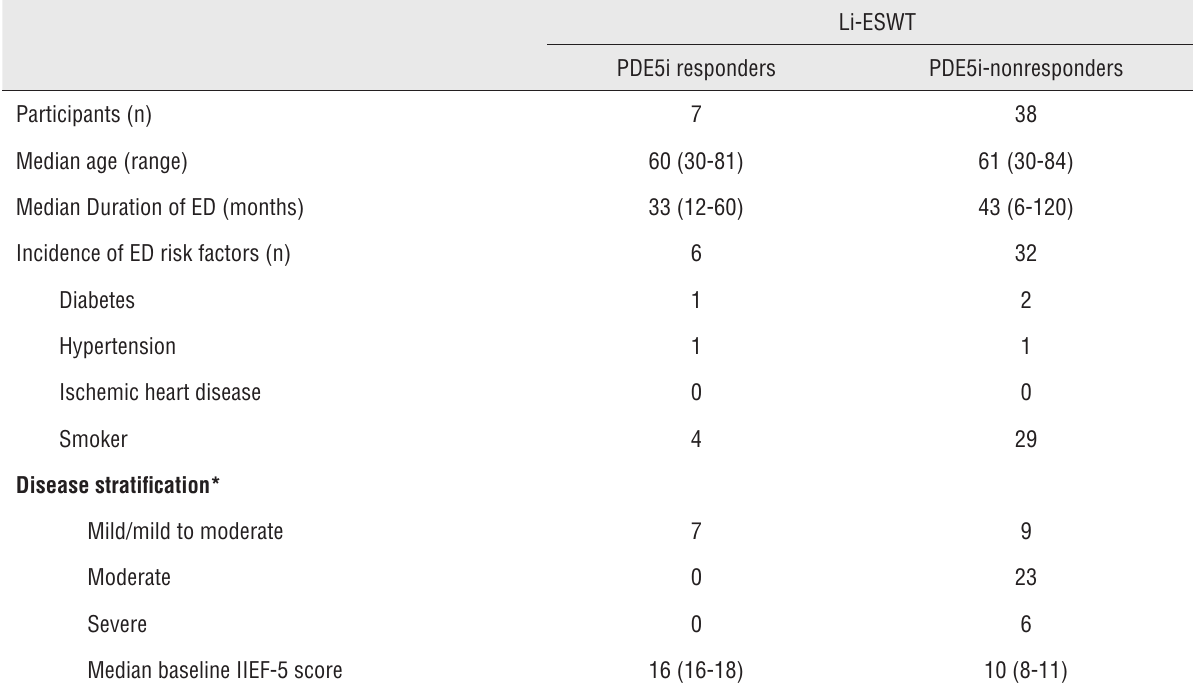
Table 1 - Baseline characteristics of study